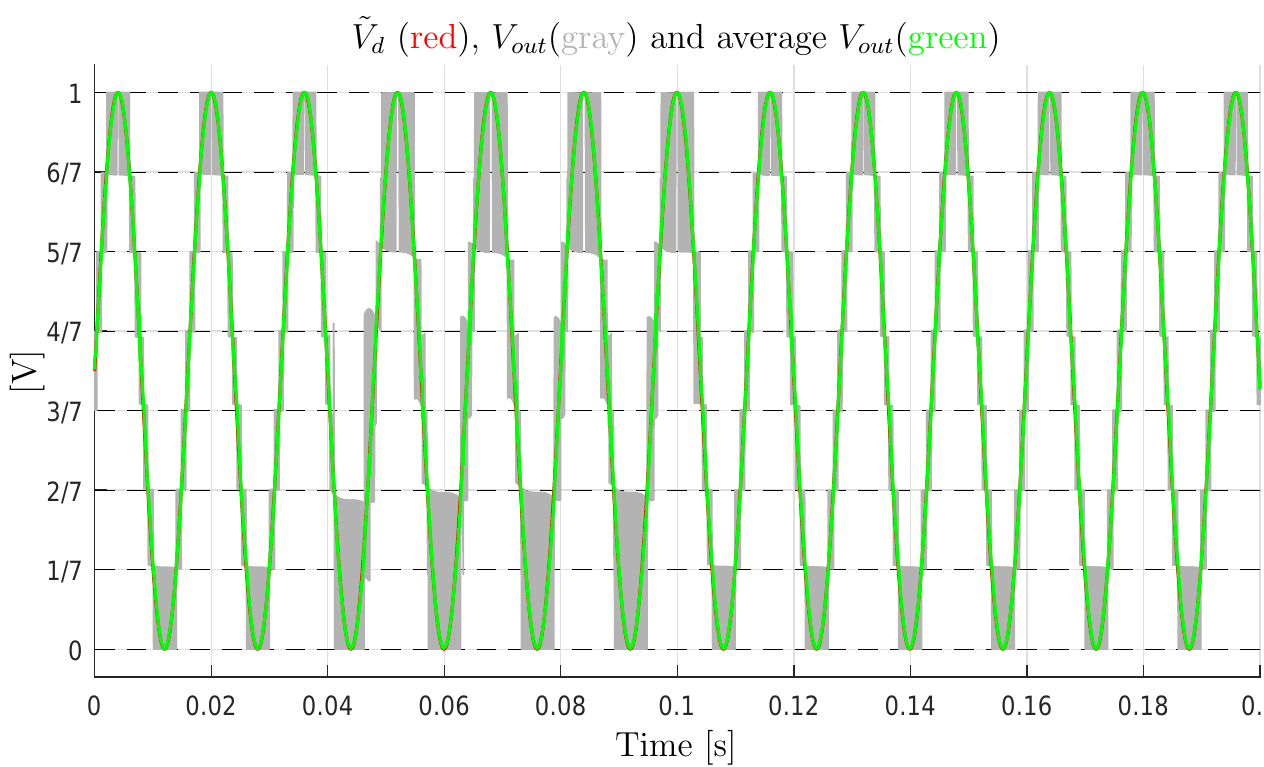
Figure 30. Non-Deformation of the output voltage waveform in the extended operation of the converter with the Configura- tion Voltage Vector V m = [ 7 6 2 ] T , in the presence of a sudden load change, thanks to the Variable-Step